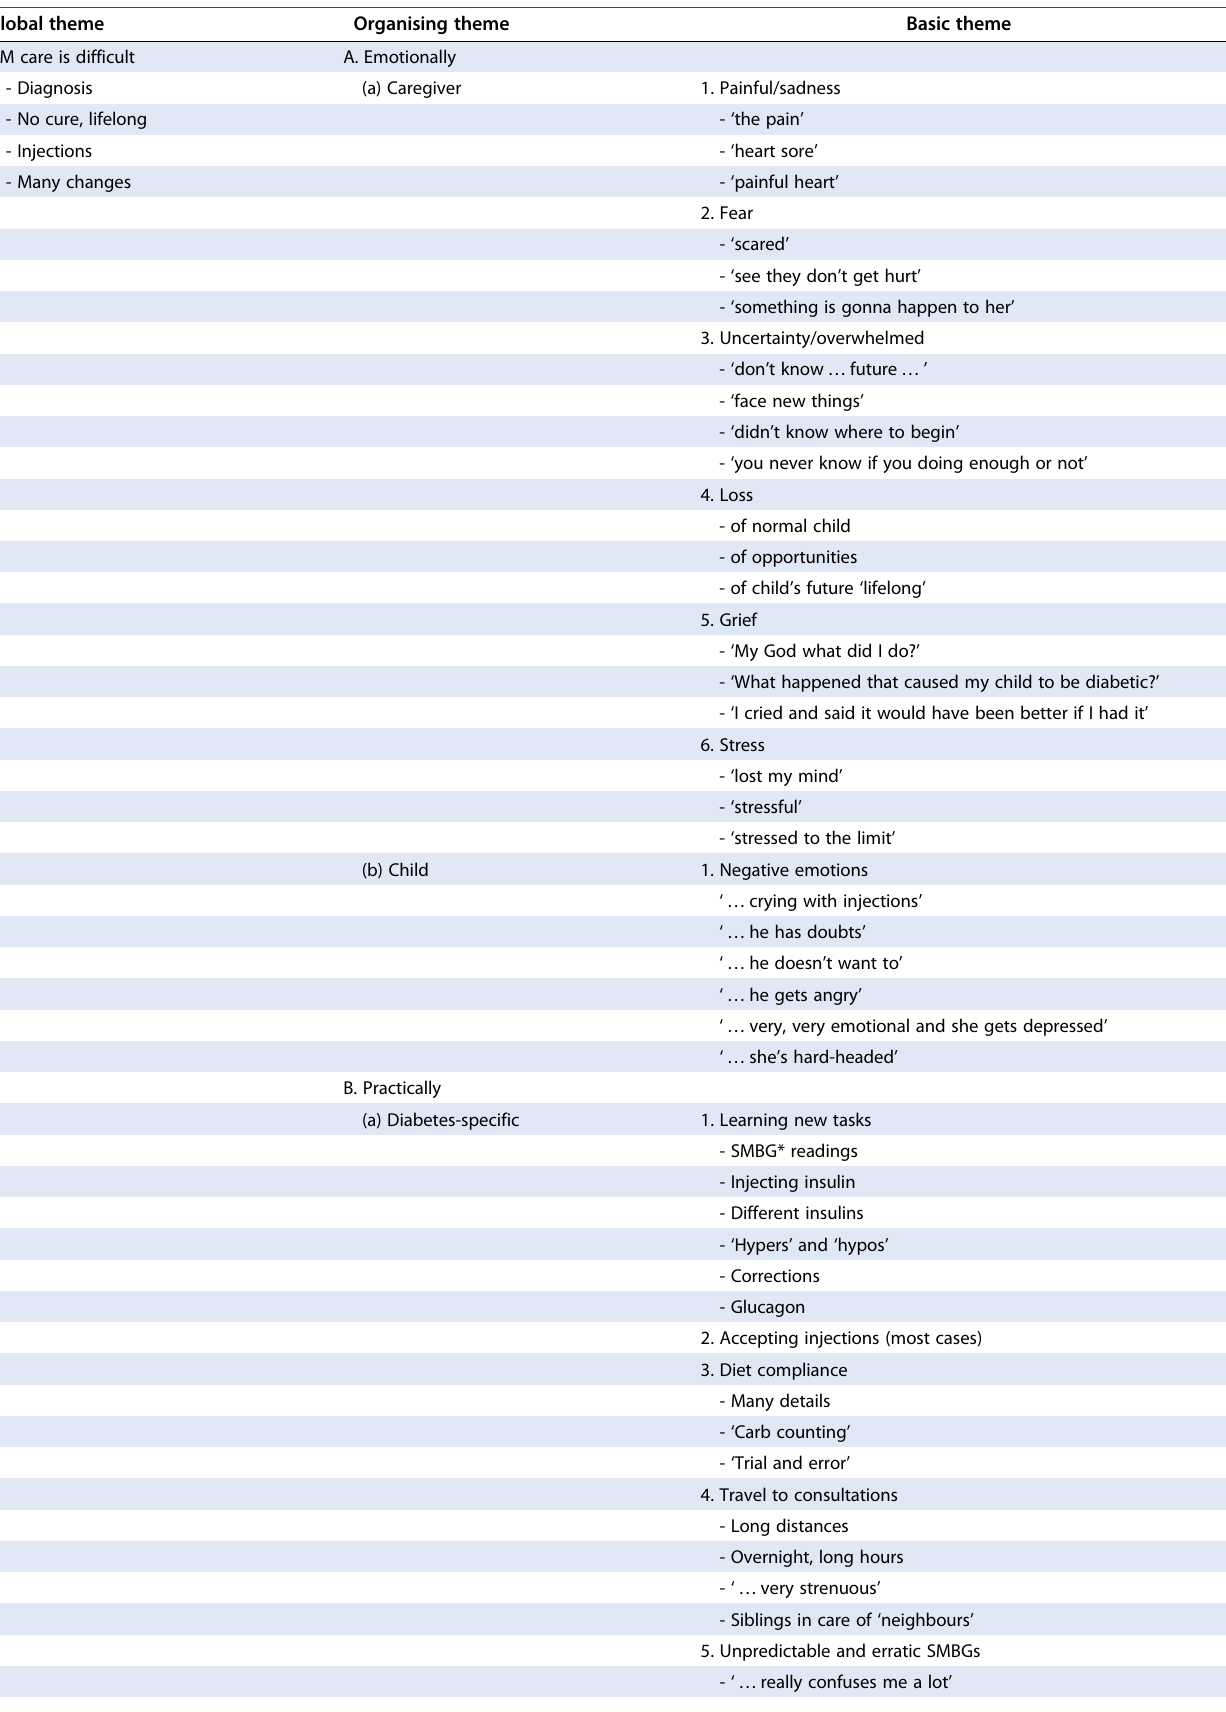
Table 3: Caregivers ’ challenges in caring for their child with DM Global